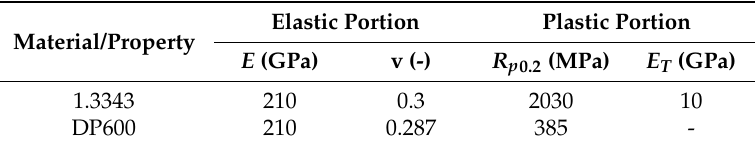
Table 1. Input material properties for material model of deformable